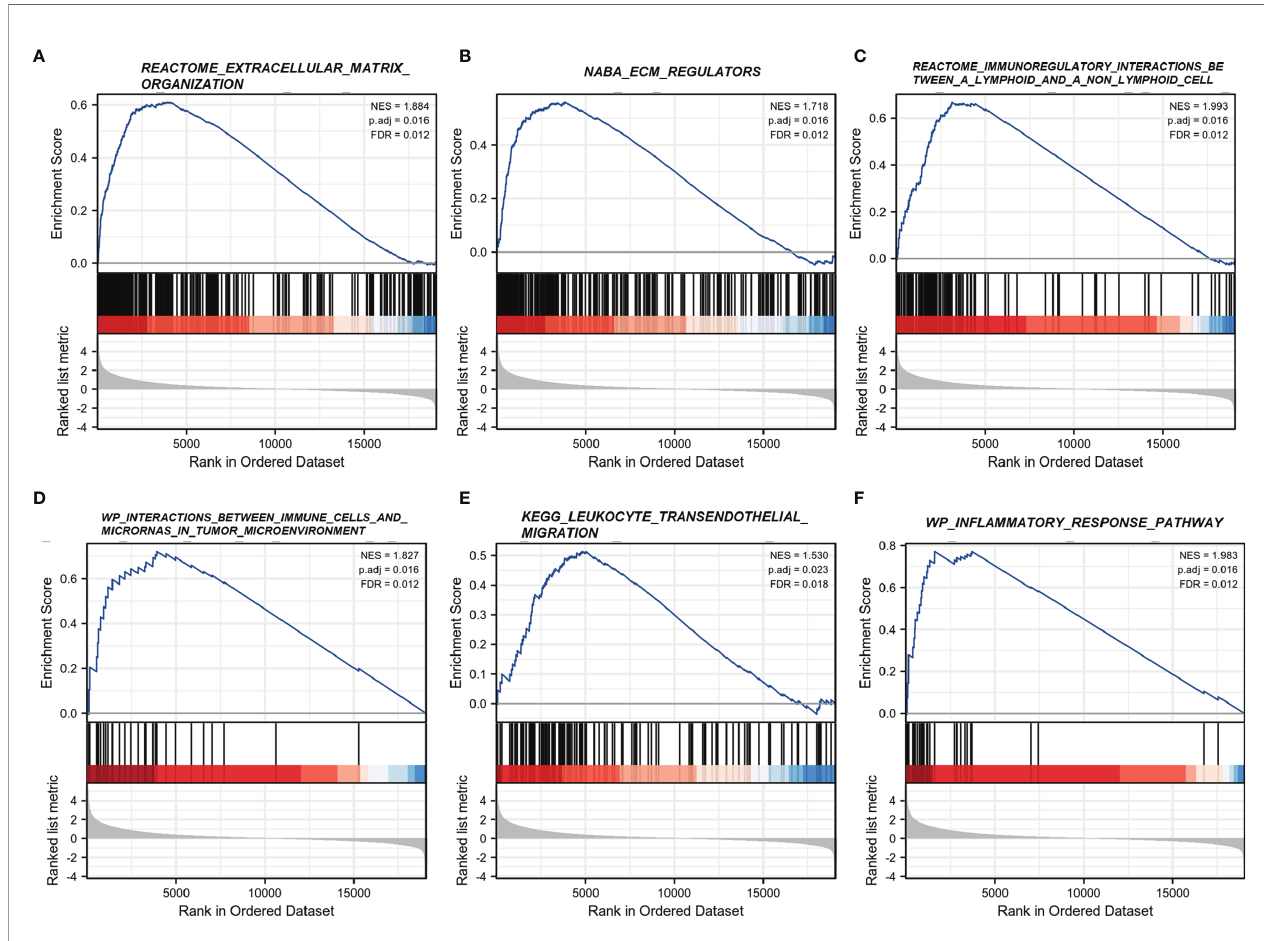
FIGURE 6 | GSEA regarding the CD101 expression level. (A) REACTOME extracellular matrix organization. (B) NABA ECM regulators. (C) REACTOME immunoregulatory interactions between a lymphoid and a non-lymphoid cell. (D) WP interactions between immune cells and microRNAs in the tumor microenvironment. (E) KEGG leukocyte transendothelial migration. (F) WP in fl ammatory response